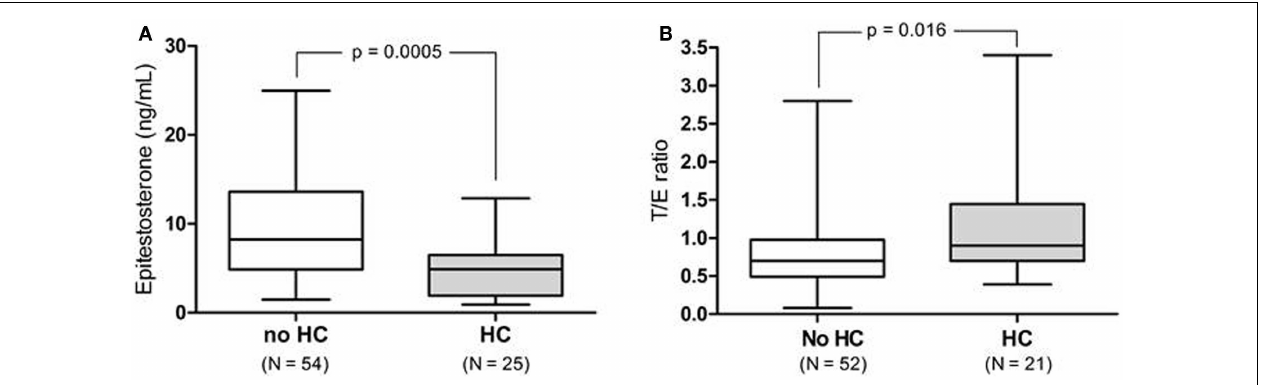
FIGURE 1 | (A) Urinary epitestosterone concentration in elite female athletes not taking hormonal contraceptives (non-HC) as compared to those on HC. (B) T/E ratio for the same athletes after removing the UGT2B17 del / del individuals ( N = 6).